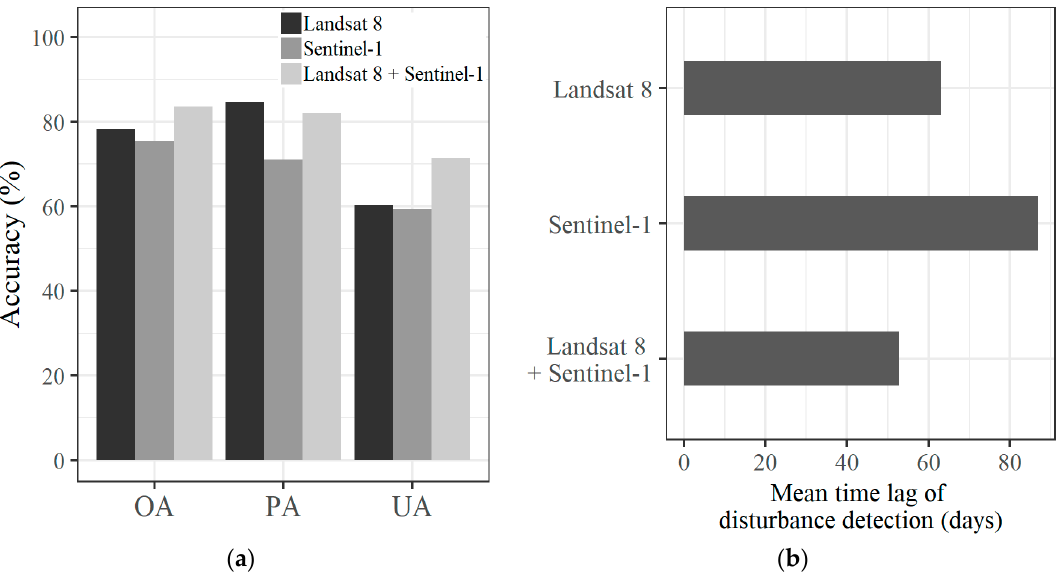
Figure 6. Accuracy of disturbance detection in terms of ( a ) overall accuracy (OA), producer’s accuracy (PA) and user’s accuracy (UA) of disturbance, and ( b ) mean time lag of the detection of disturbance using only Landsat 8, using only Sentinel-1 and combining Landsat 8 and Sentinel-1.